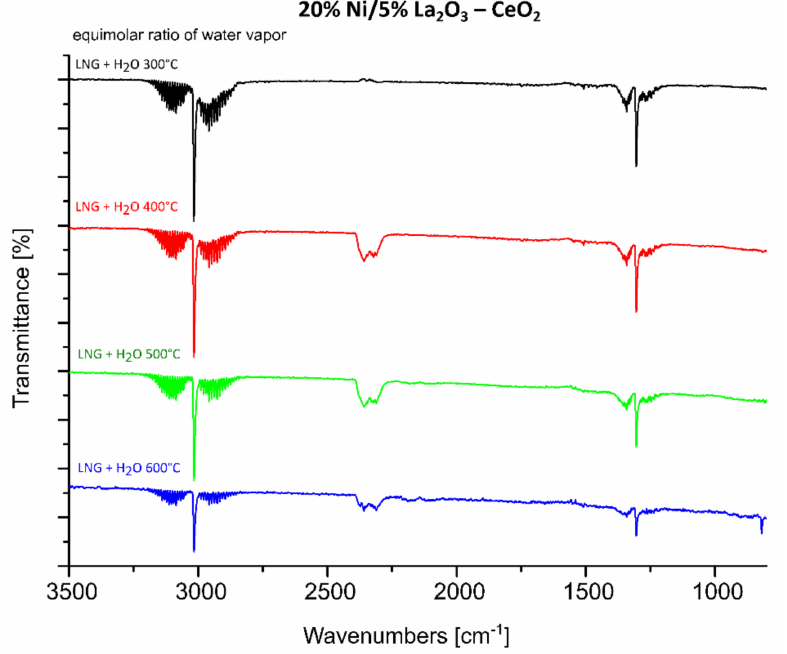
Figure 9. In situ IR spectra under steam reforming of LNG conditions in the temperature